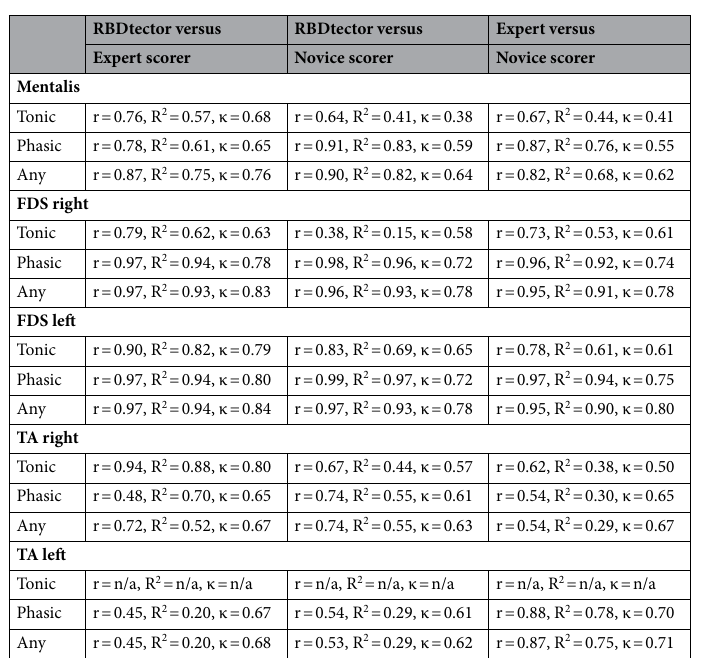
Table 3. Metrics of agreement between RBDtector and human scorers. iRBD idiopathic rapid eye movement sleep behaviour disorder, FDS flexor digitorum superficialis muscle, TA tibialis anterior muscle, n/a not applicable (not enough